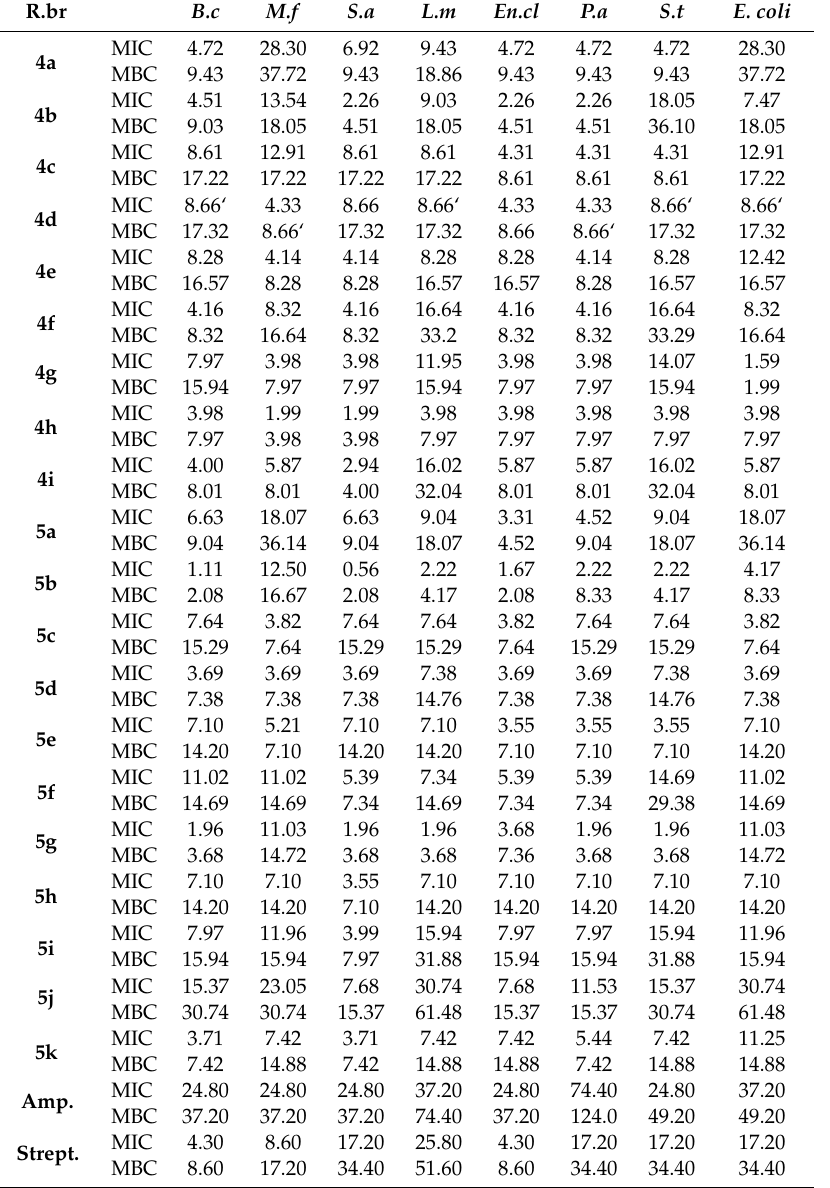
Table 1. Antibacterial activity of compounds ( µ M × 10 − 2